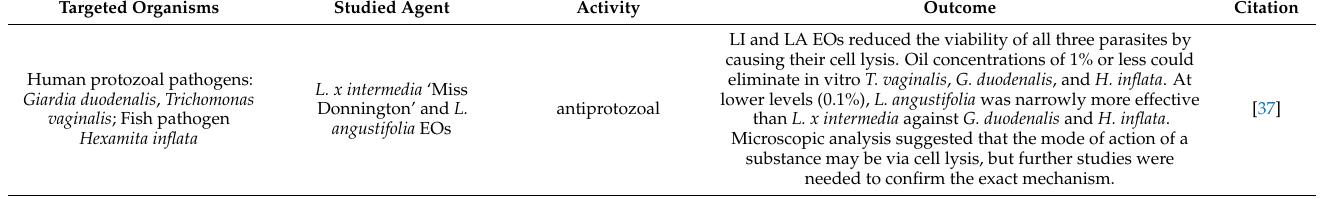
Table 2. Other than the antimicrobial biocidal activities of lavandin natural products reported in the literature. Only original research articles were